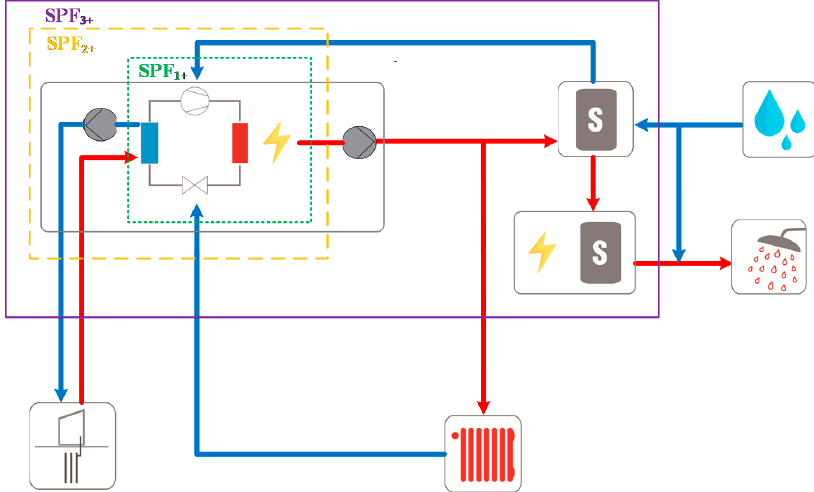
Figure 7. Annex 52 boundary levels 1 + , 2 + , and 3 + applied to the clubhouse GSHP system. Pictograms in drawing used with permission from TU Braunschweig IGS. Table 4. Formulas to calculate seasonal performance factors based on the Annex 52 boundary scheme.